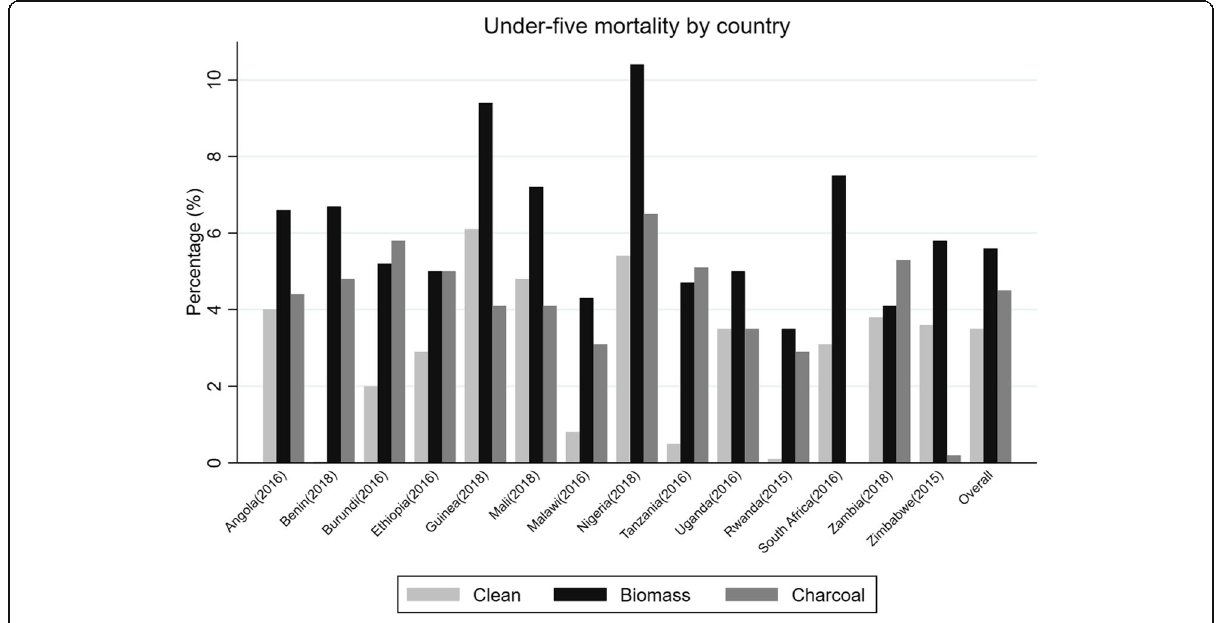
Fig. 1 Percentage of under-five mortality by